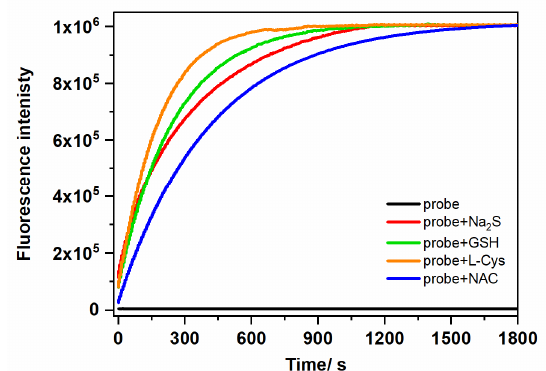
Figure 1. The time-dependent fluorescence intensity at 473 nm for NBD-O-CmCH 2 OH (5 μ M) in the absence or the presence of various thiol species (50 μ M) in PB buffer (0.1 M, pH 7.4, containing 10% MeCN, v/v ). Table 1. Rate constants and limit of detection for reactions of hydrogen sulfide and the low-molecular- weight thiols cysteine, N -acetyl-L-cysteine, and glutathione with the studied